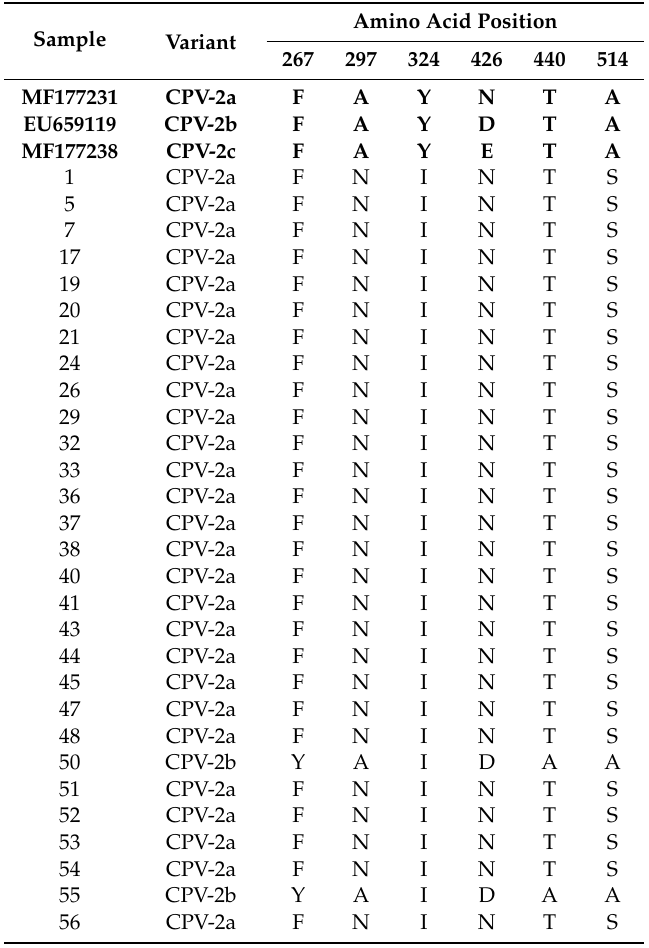
Table 2. Amino acid variations in the samples identified as CPV-2a and CPV-2b in relation to reference variants (in